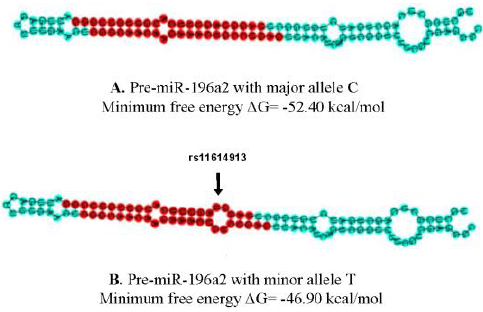
Figure 2. Schematic view of the predicted pre-miR-196a-2 hairpin structure containing the SNP major allele C or minor allele T. The minimum free energy (MFE) change of the thermodynamic ensemble ( ∆ G) is shown. The red part indicates mature sequence and the blue part shows the rest of pre-miRNA sequence.